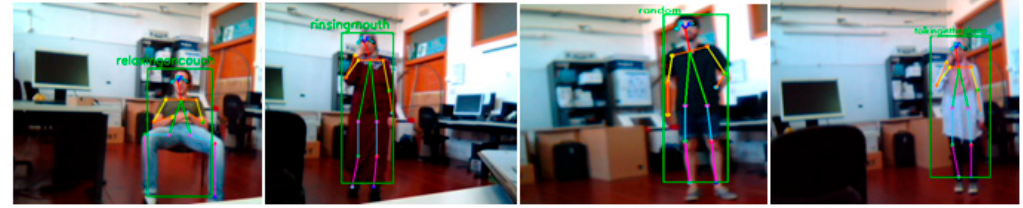
Figure 8. Some activities classified for four people in the UIB lab: relaxing on the couch, rinsing teeth, random, and talking on the phone.